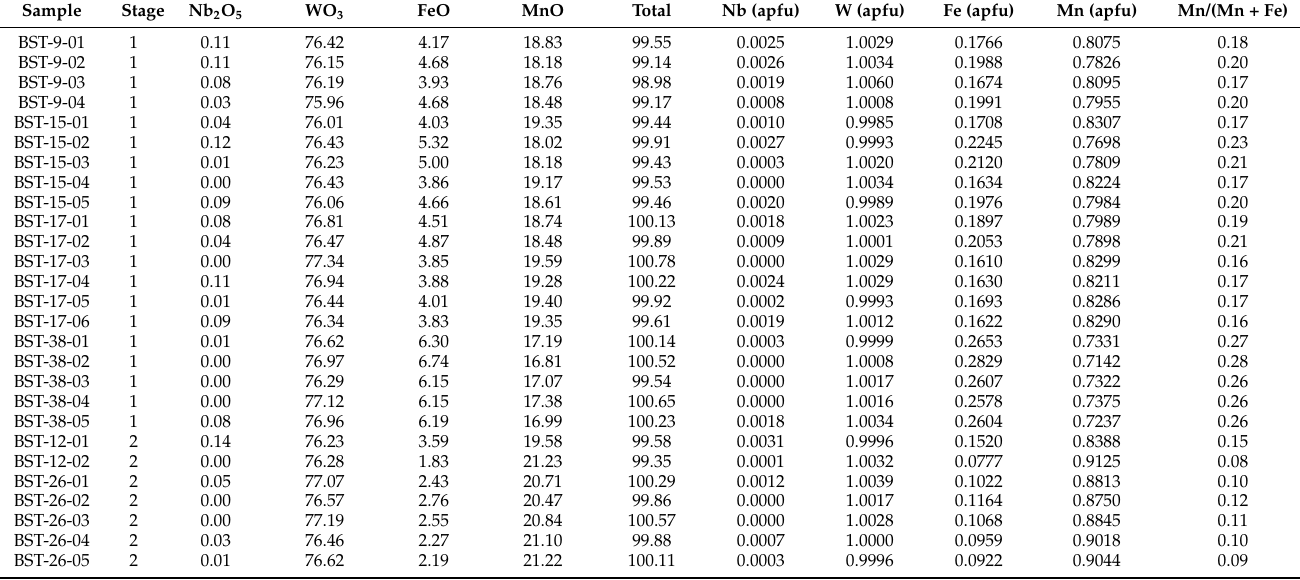
Table 2. Chemical composition of wolframite by EPMA (in